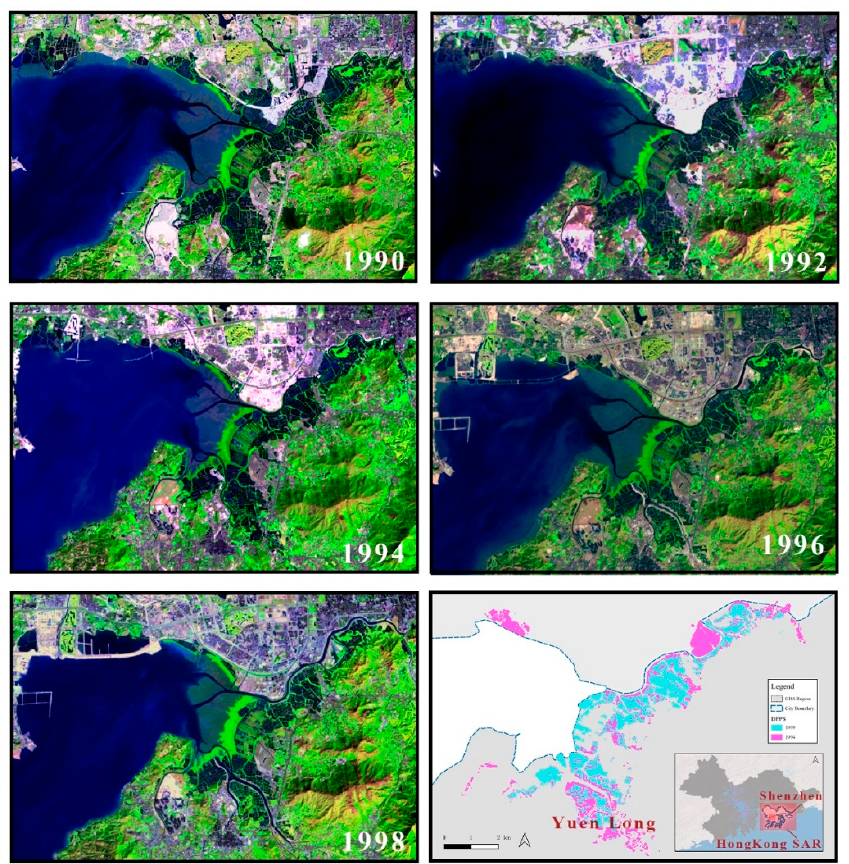
Figure 16. The rapid shrinkage of fish ponds in Shenzhen and Hong Kong SAR in the 1990s. The fish ponds in Shenzhen are mainly concentrated in the original Bao’an County.